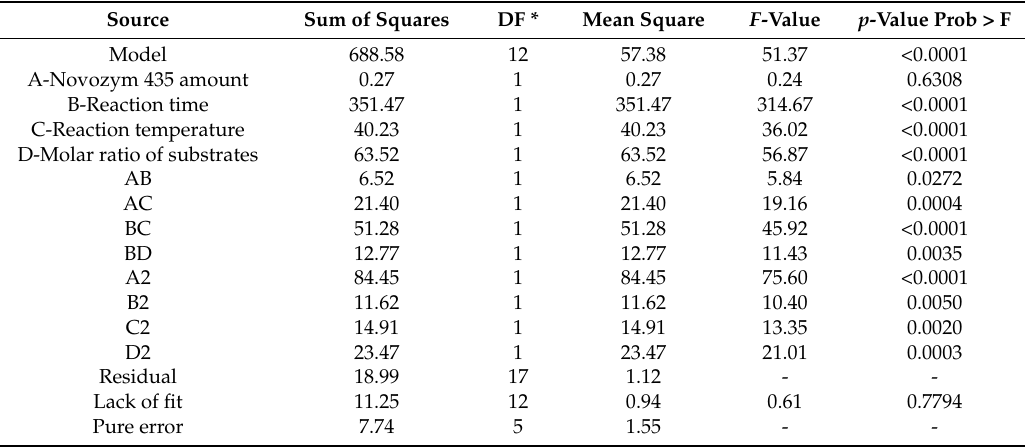
Table 3. Analysis of variance (ANOVA) for the quadratic model developed for synthesis of dilaurylazelate